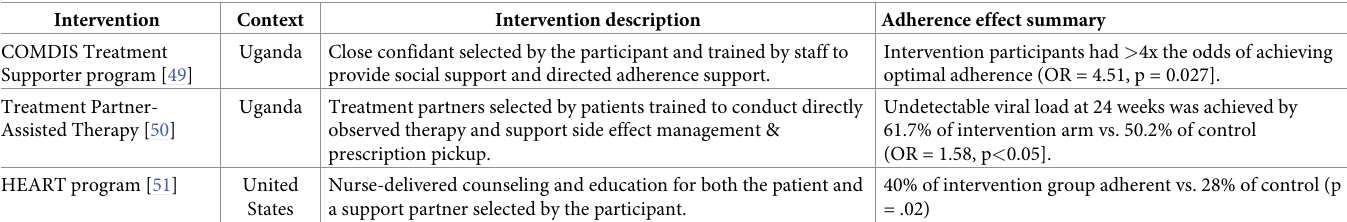
Table 2. Prior adherence support interventions informing social support intervention